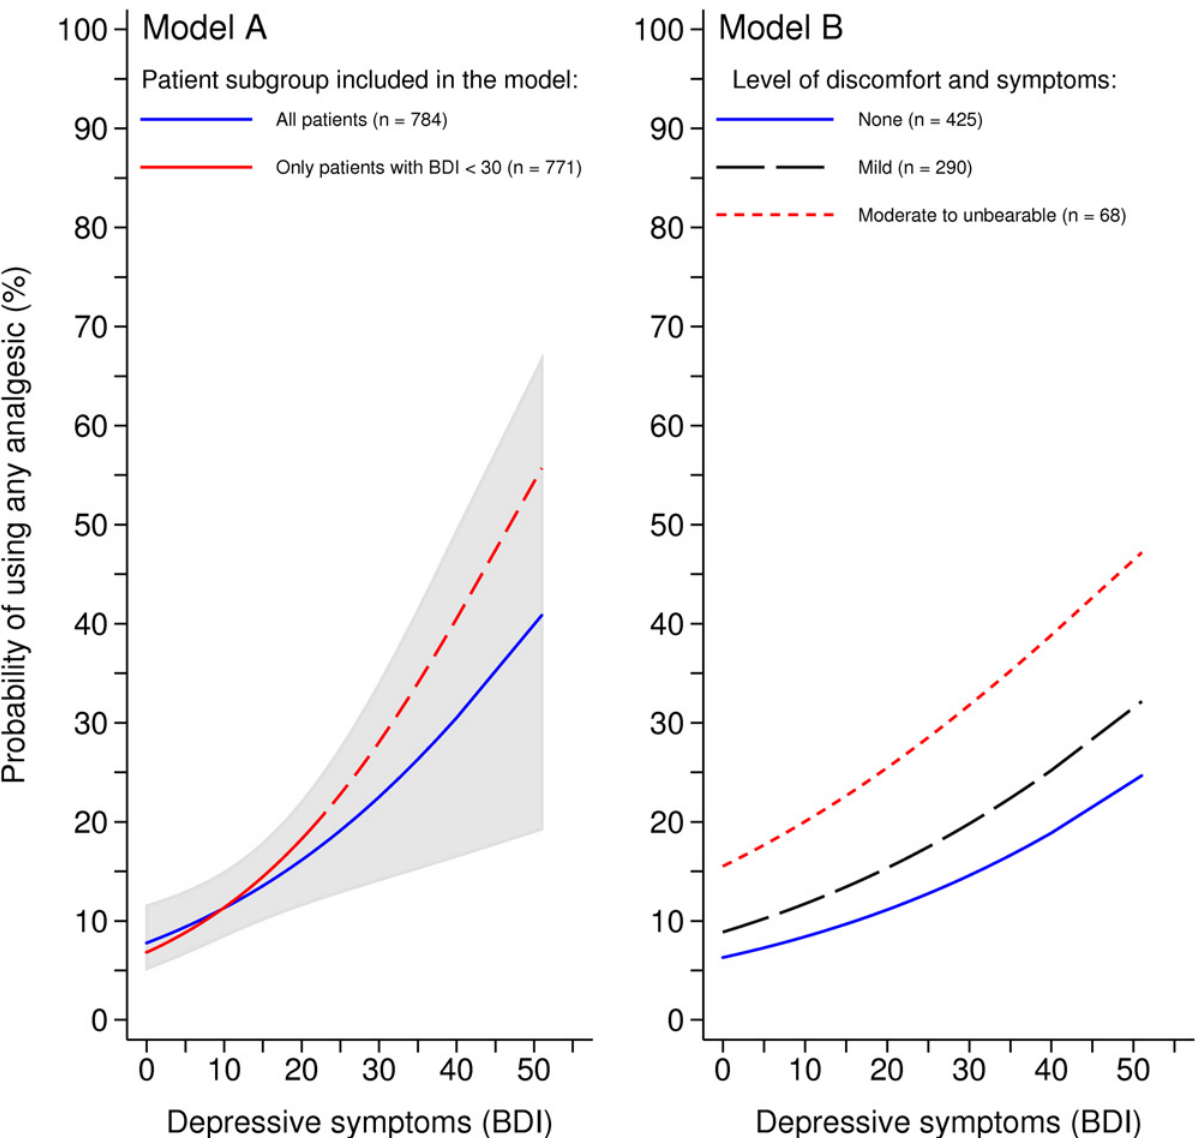
Fig 1. Adjusted probability of analgesic use in relation to depressive symptoms and level of discomfort (means and CIs) in persons with AD. Data is presented for persons with AD. Probability was estimated using GEEs with logit link function, binomial distribution and unstructured correlation matrix. Data is adjusted for age, gender, follow-up visit, years of education, CDR-SOB and comorbidities (arthritic conditions and number of other comorbidities). A BDI score (cid:1) 30 was considered to be indicative of severe depression. n represents number of observations included in the model, both individuals who use analgesics and who do